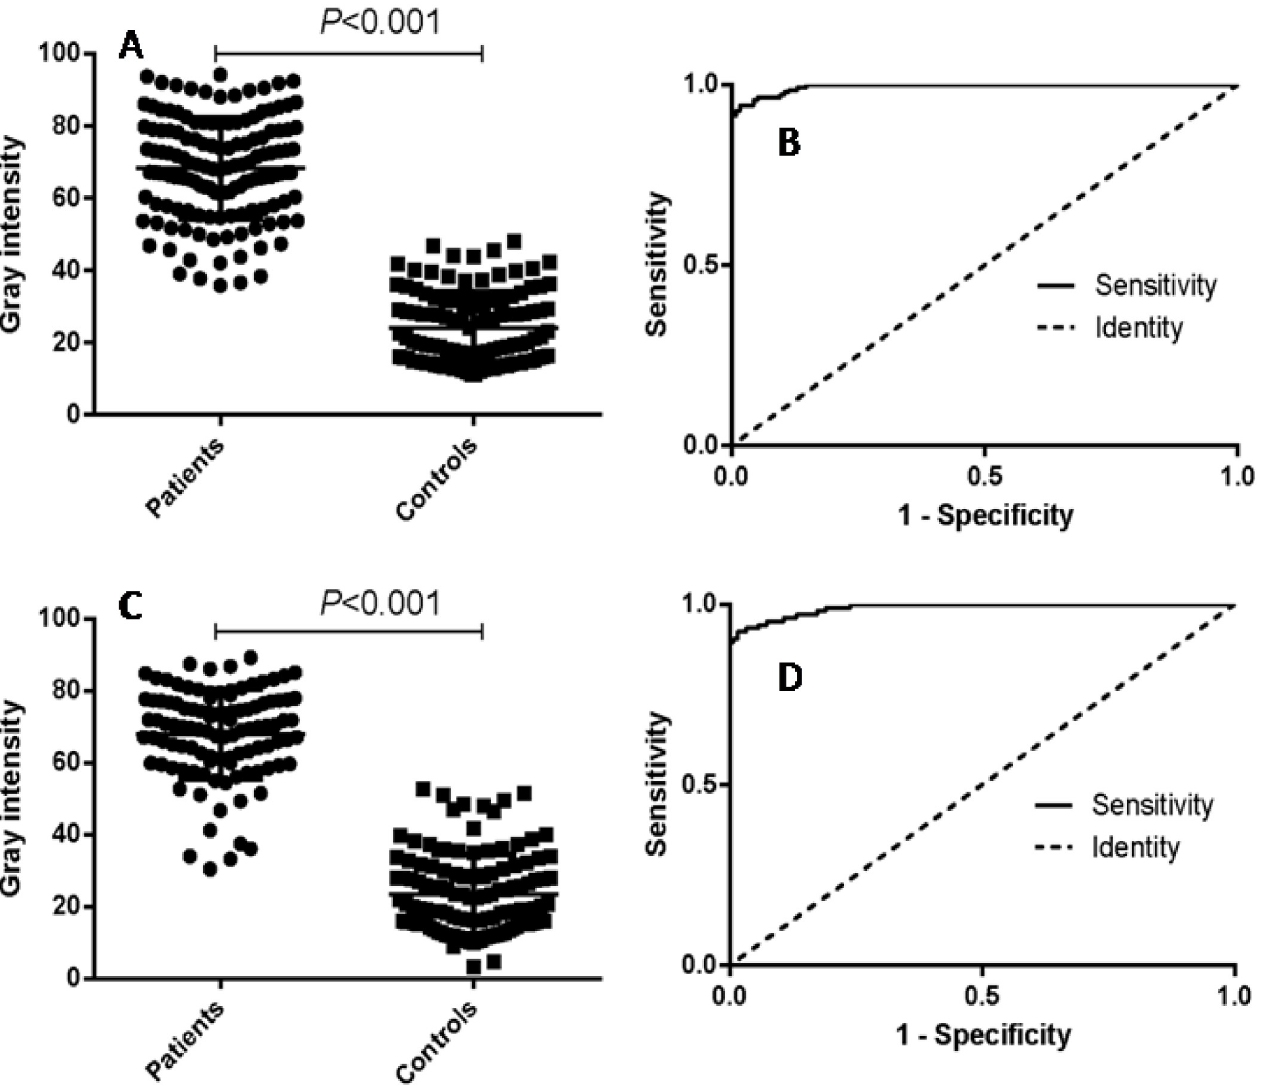
Fig 5. P-ELISA analysis of human serum samples. (A) Dotplotresult of the nano-p-ELISA assay. (B) ROC analysis of nano-p-ELISA assay results. ( C) Dotplot result of tra-p-ELISA assay. (D) ROC analysis of tra-p-ELISA assay